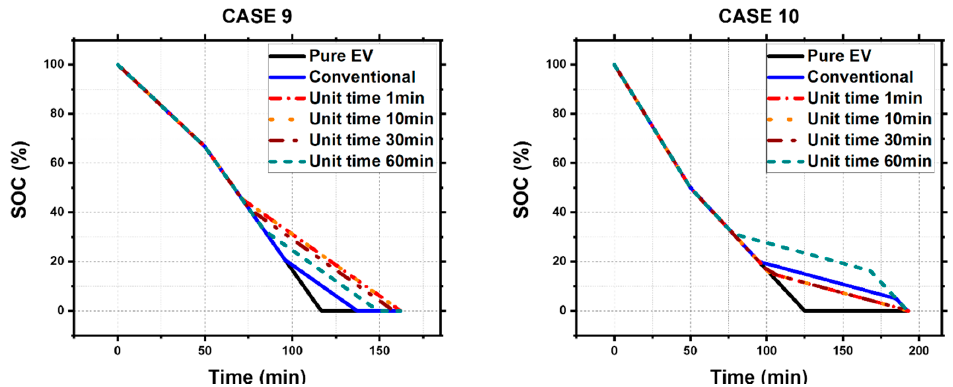
Figure 6. Simulation results for power consumption scenarios.